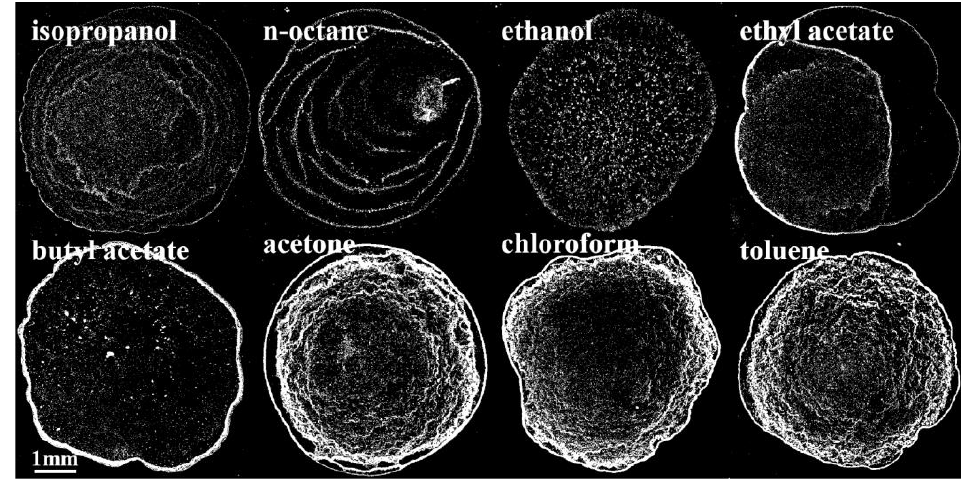
Figure 1. Morphologies of films prepared with different QD inks.